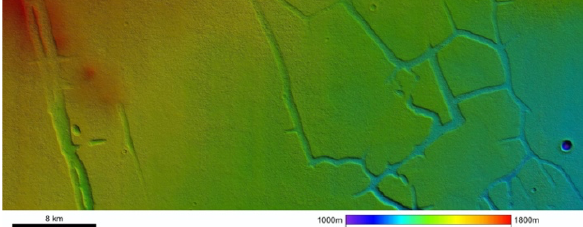
Figure 9. Example of CTX-DTM with colourisation by height and hill-shading using a standardised illumination geometry (30º SZA and 330º SAZ) generated as part of the global 2,375